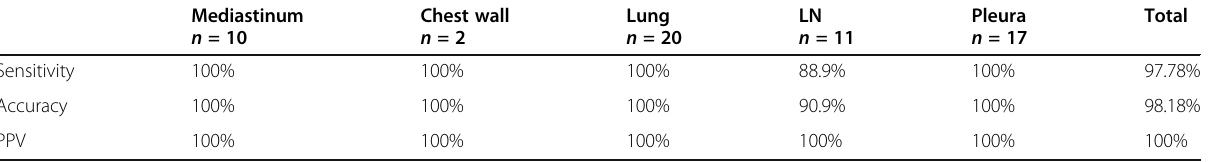
Table 12 Sensitivity, PPV and accuracy of Tru-Cut biopsy for diagnosis as regarding the site of